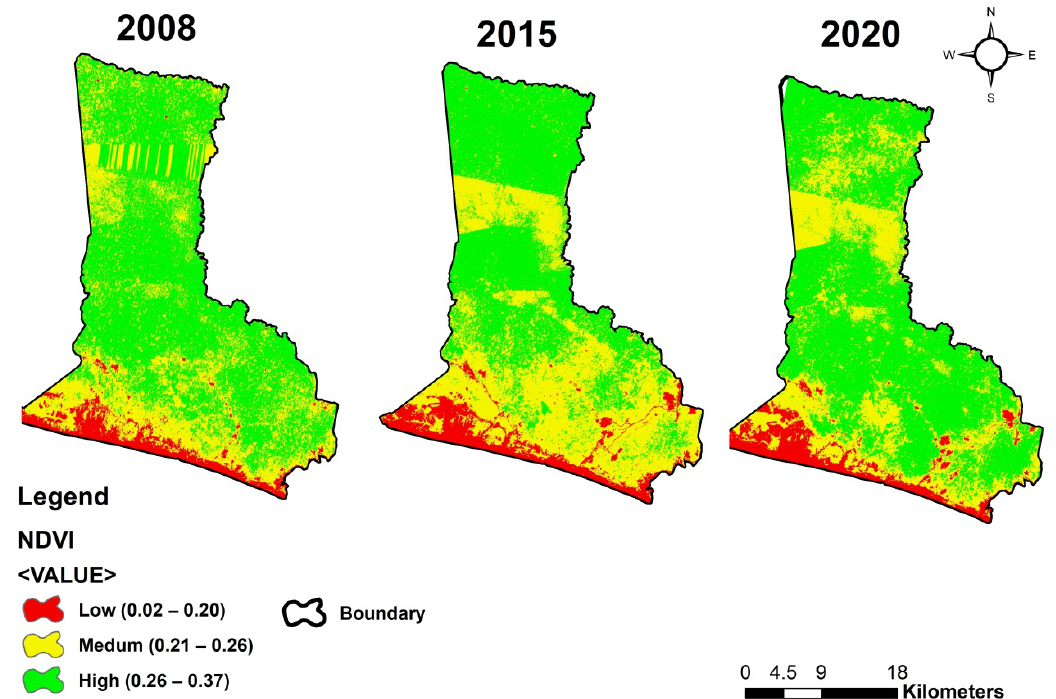
Figure 5. NDVI density maps for 2008, 2015, and 2020.